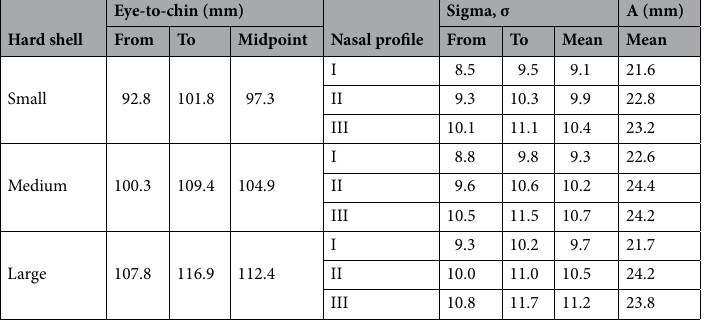
dashed lines (arrows) indicate the moment of the vapour injection and horizontal dashed lines show the approxi- mate count relating to vapour observed through the translucent filter area. Both the ‘Medium’(II) (Fig. 6b) and